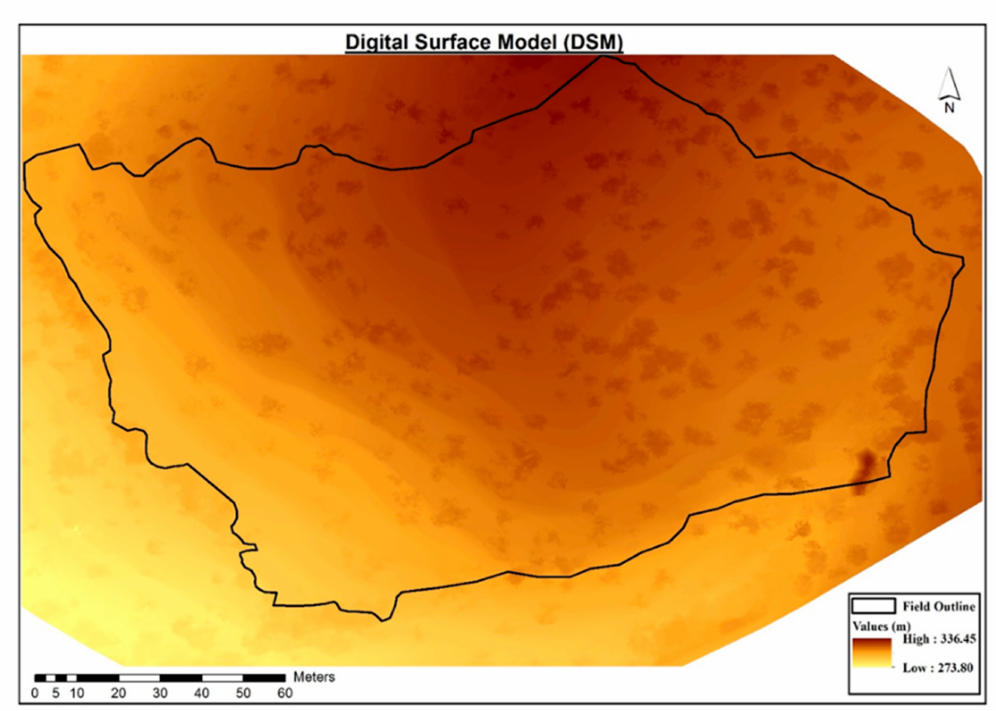
Figure 3. Digital Surface Model (DSM) of the study